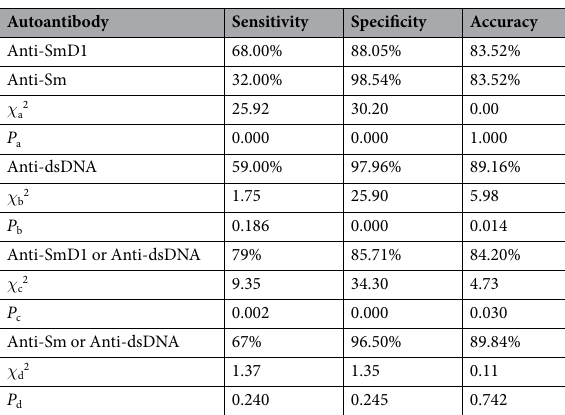
Table 2. Diagnostic performance of the anti-SmD1, anti-Sm and anti-dsDNA antibodies. Note: a, analyses between anti-SmD1 and anti-Sm; b, analyses between anti-SmD1 and anti-dsDNA; c, analyses between anti-